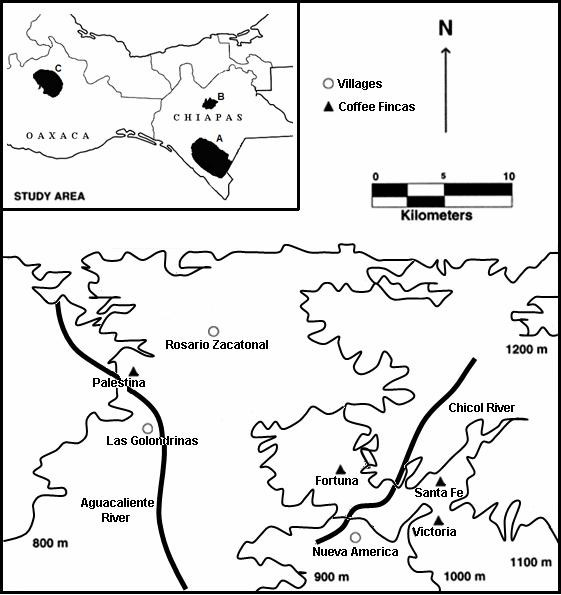
Map of the Mexican-Guatemalan border area showing the geographical location of the three villages and four coffee fincas studied within the southern Chiapas focus endemic for human onchocerciasis, Mexico (indicated by A in the inset).